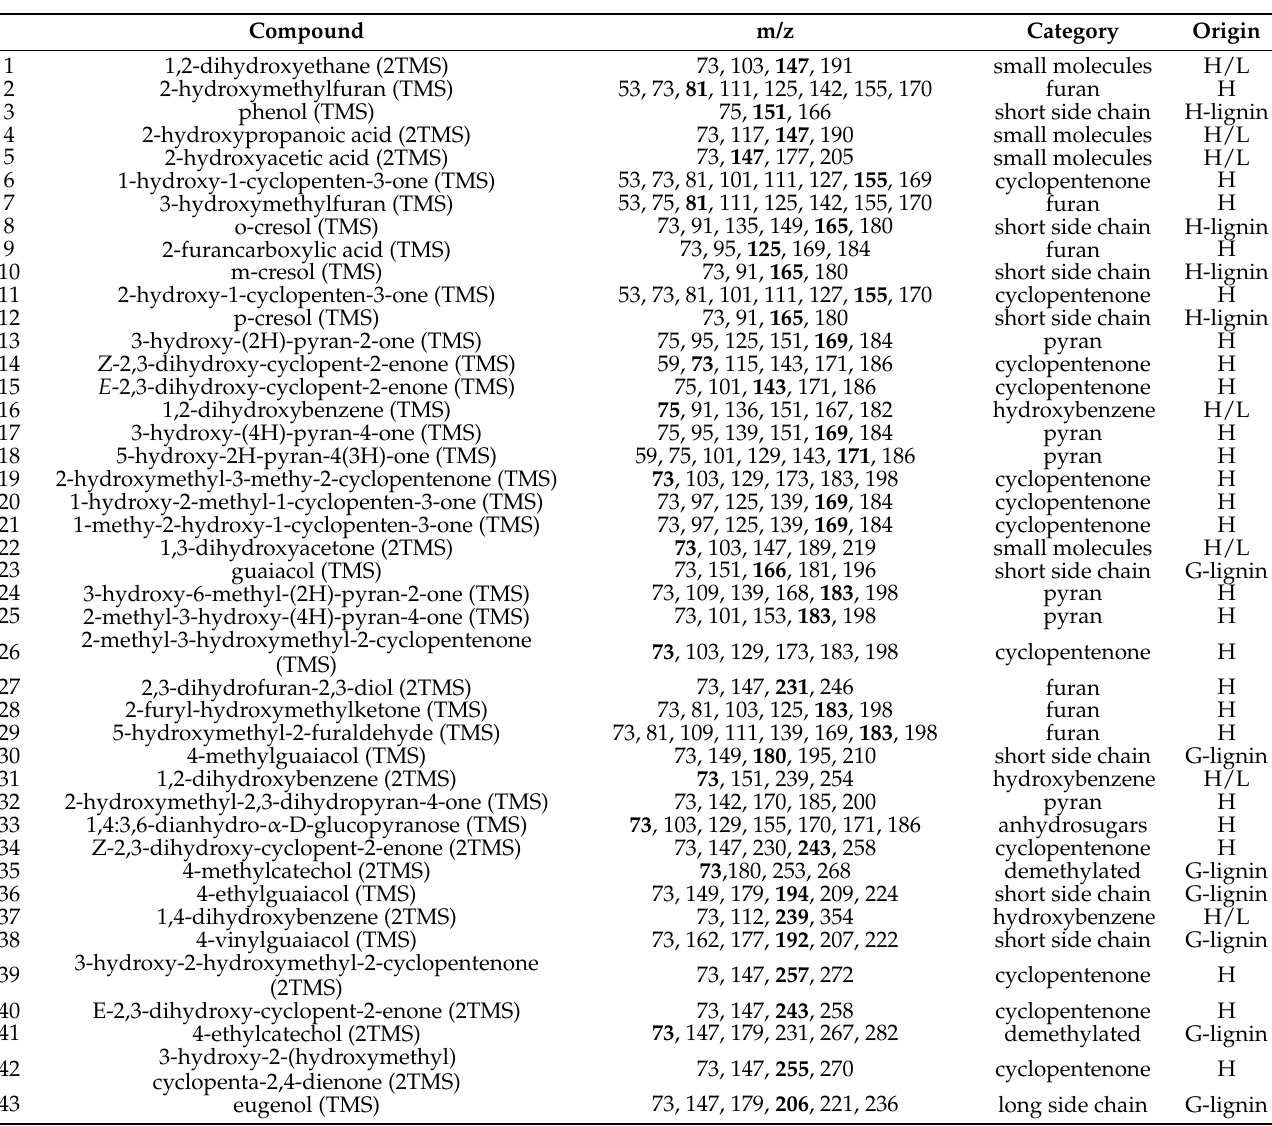
Table 5. The pyrolysis products identified by Py-GC/MS and categorised were H-holocellulose, L-lignin, lignin units: p-hydroxyphenyl (H-lignin), and guaiacyl (G-lignin), in bold more abun- dant